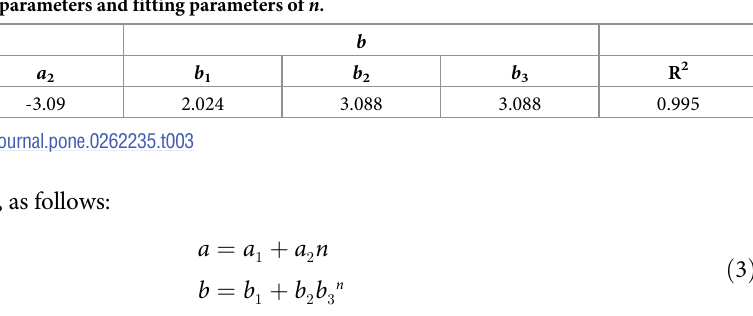
PLOS ONE | https://doi.org/10.1371/journal.pone.0262235 January 18,